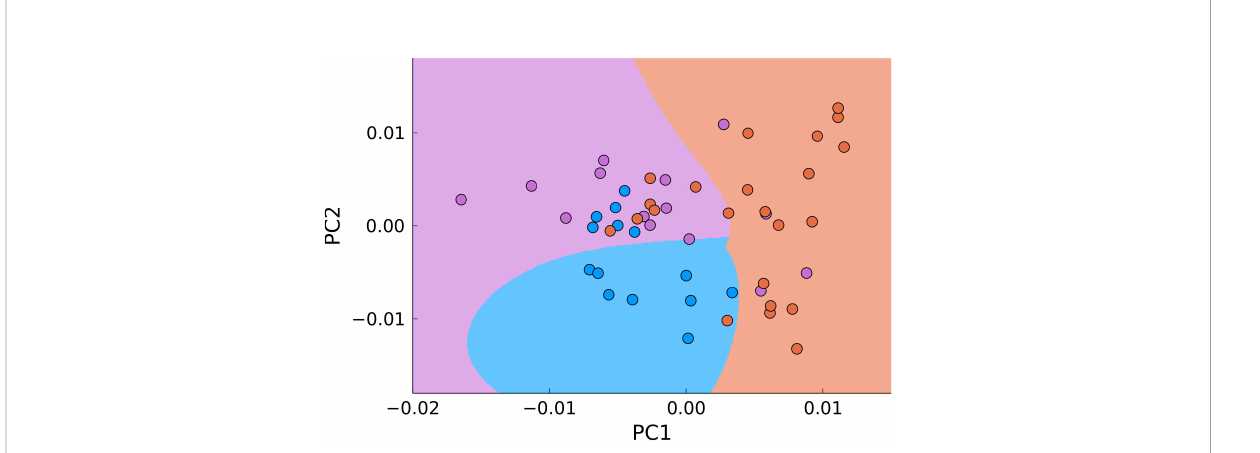
FIGURE 7 PCA of all points in the range of 900 – 1800 cm -1 (blue – normal tissue, magenta - tumor edge, orange - tumor center). The background color signi fi es the classi fi cation by SVM.